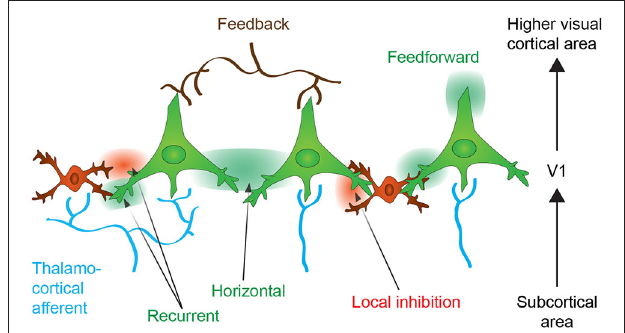
FIGURE 3 | Neuronal connectivity within the primary visual cortex (V1) . Neurons from V1 receive thalamocortical (in blue) and corticocortical inputs originating from upper cortical areas (feedback control, in brown). The thalamocortical information is integrated within V1 and further transmitted to upper cortical areas (feedforward transmission). The activation of neurons might enhance activation or inhibition of neighboring neuron by the horizontal connections or through the local inhibitory interneurons. Recurrent connections auto-regulates neuronal activity (see text for more details). Excitatory effect is expressed as green color and inhibitory effect as